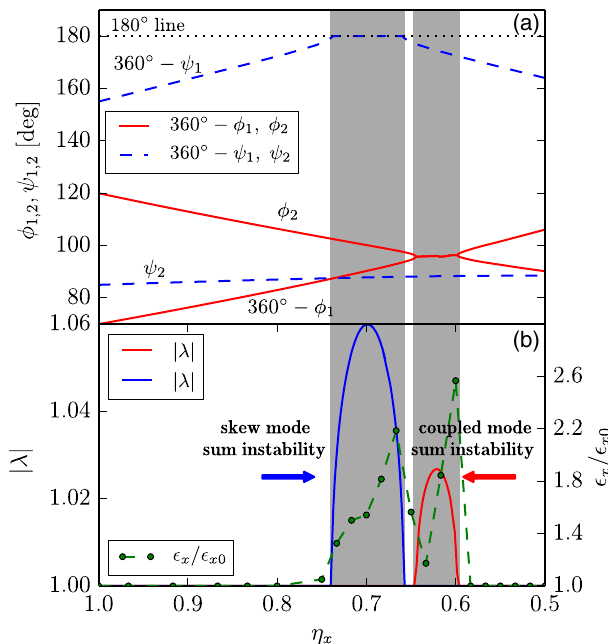
FIG. 5. Perturbation theory results for both types of sum envelope instabilities in a periodic focusing system. Upper plot (a): Phase shifts of ϕ 1 ; 2 , ψ 1 ; 2 verses tune depression in x ; Lower plot (b): Corresponding growth factors per lattice period (con- tinuous lines), and comparison with final emittance growth factors (dashed lines, normalized to initial values) for PIC simulation of same cases.